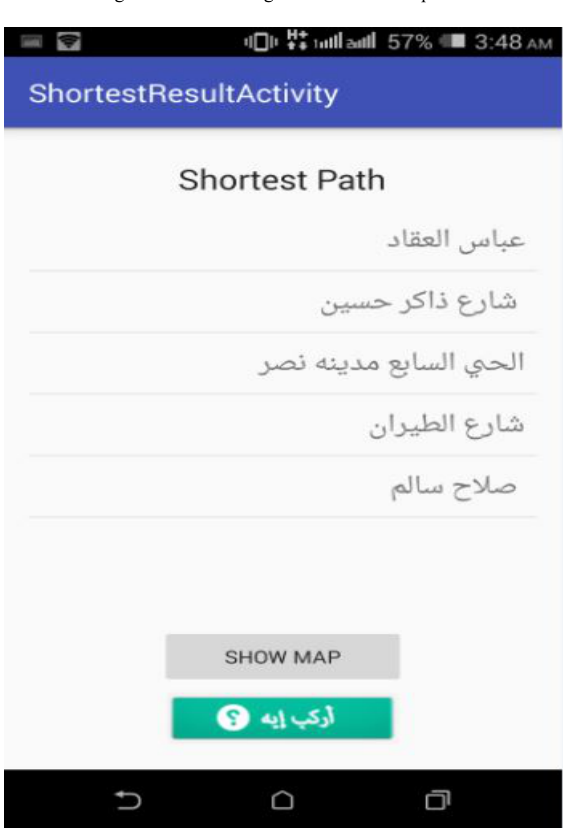
Figure 6. Result of clicking available buses